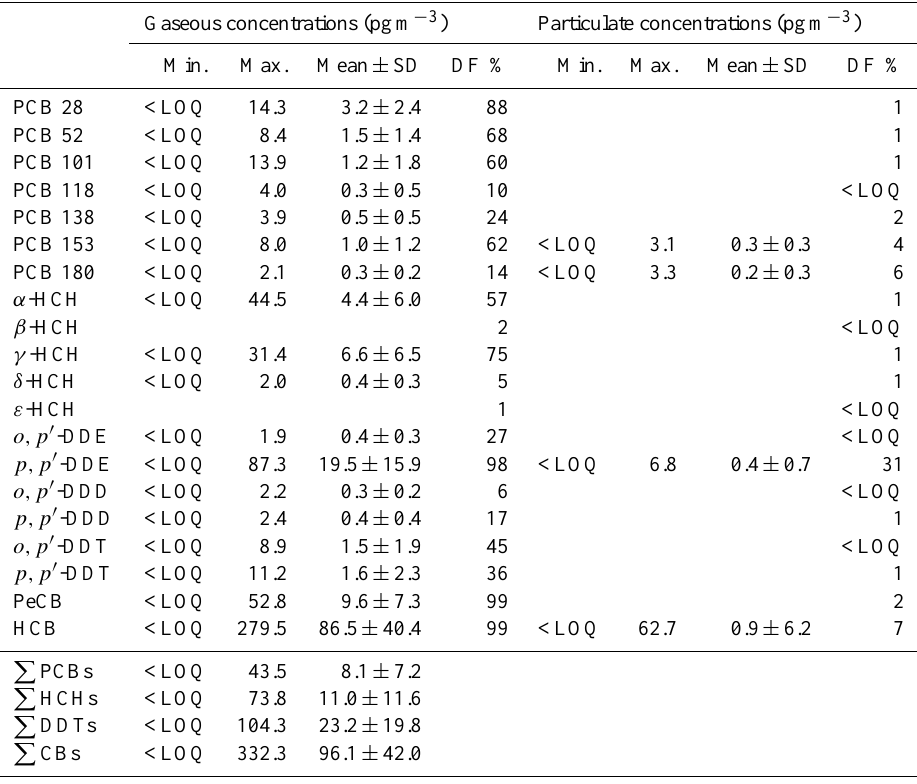
Table 2. PCB and CP concentrations and detection frequencies (DF) in air ( n = 162). Gaseous concentrations (pgm − 3